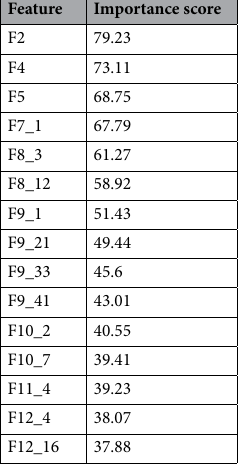
Table 3. Important features selected by Boruta.